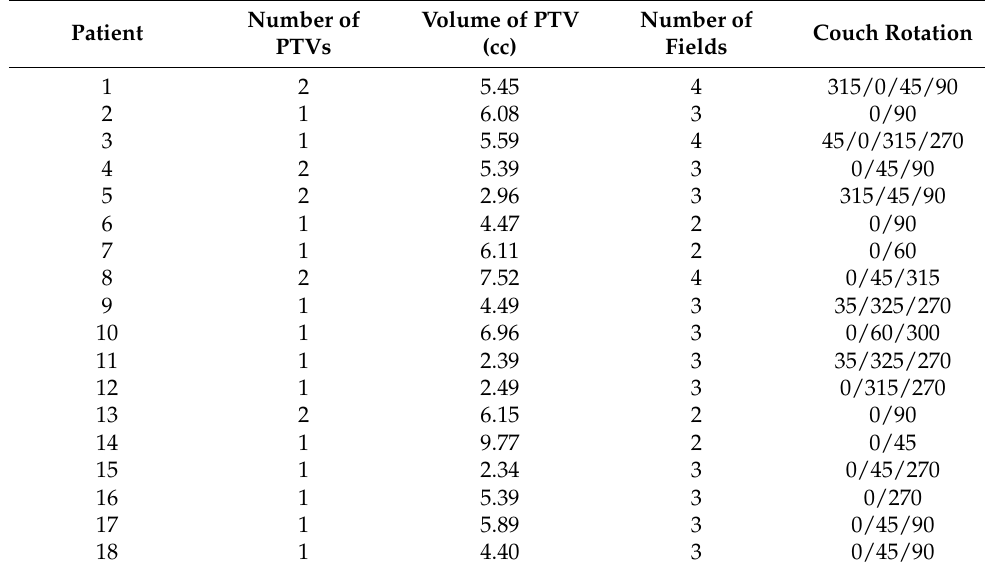
Table 2. Tumor volume and beam